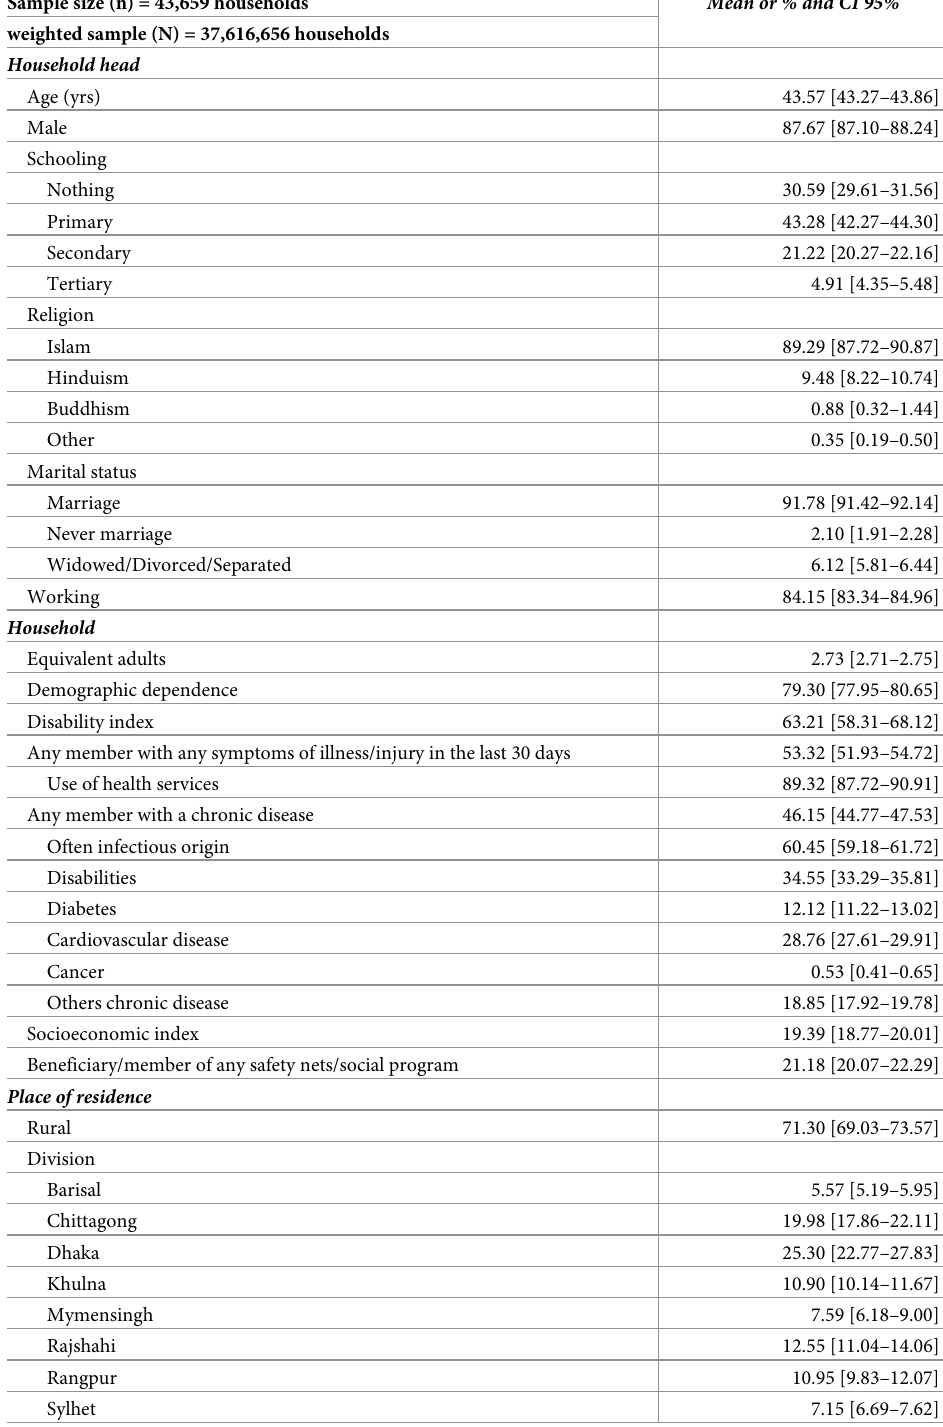
Table 1. Main household characteristics. HIES, Bangladesh,